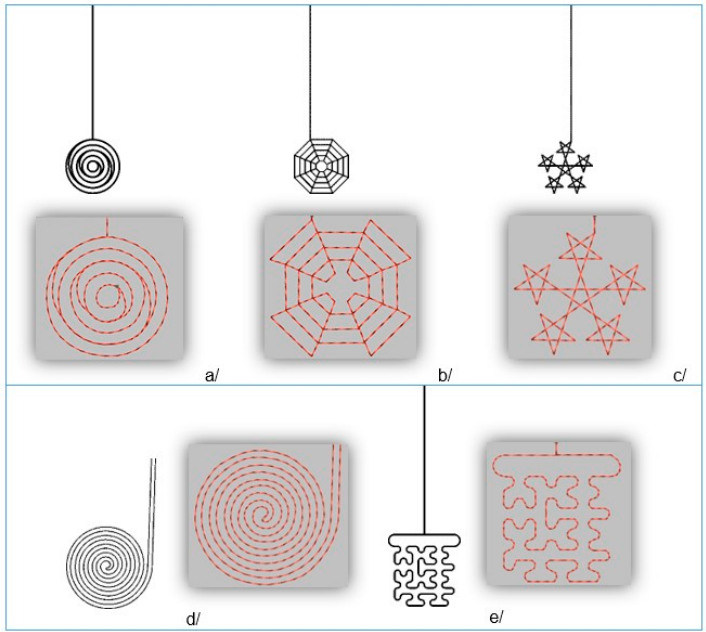
Figure 7. Design of the sensor patterns: ( a ) concentric circles; ( b ) cobweb; ( c ) five ‐ pointed star; ( d ) spiral; ( e ) Hilbert curve.